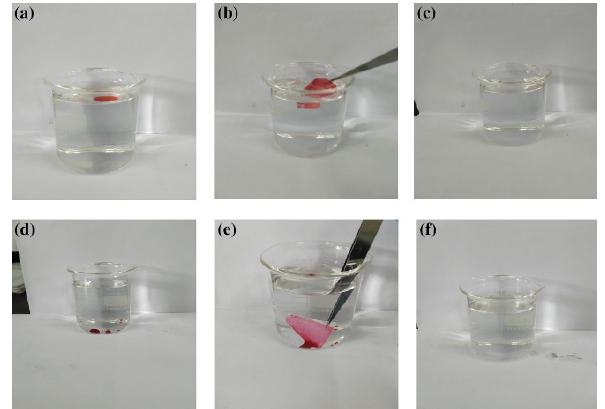
Figure 16. ( a – c ) Fluorinated polymeric sol-gel incorporated fabric on hexane removal and ( d – f ) chloroform with the help of water (Reproduced from [138], with kind permission of Wiley).